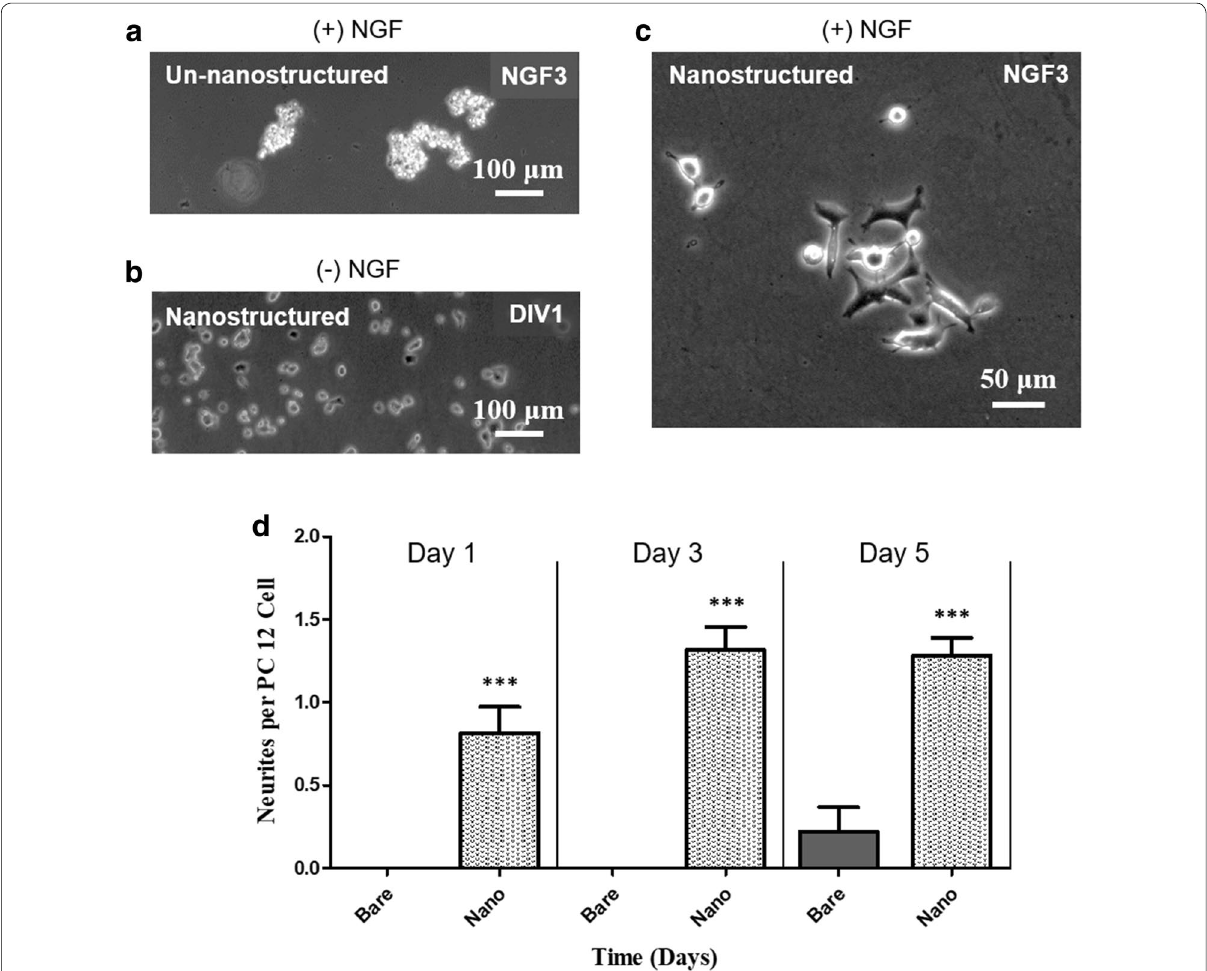
Fig. 5 Phase‑contrast optical images of rat PC12 cells cultured on nanostructured and non‑nanostructured microprobes. a At 3 days after